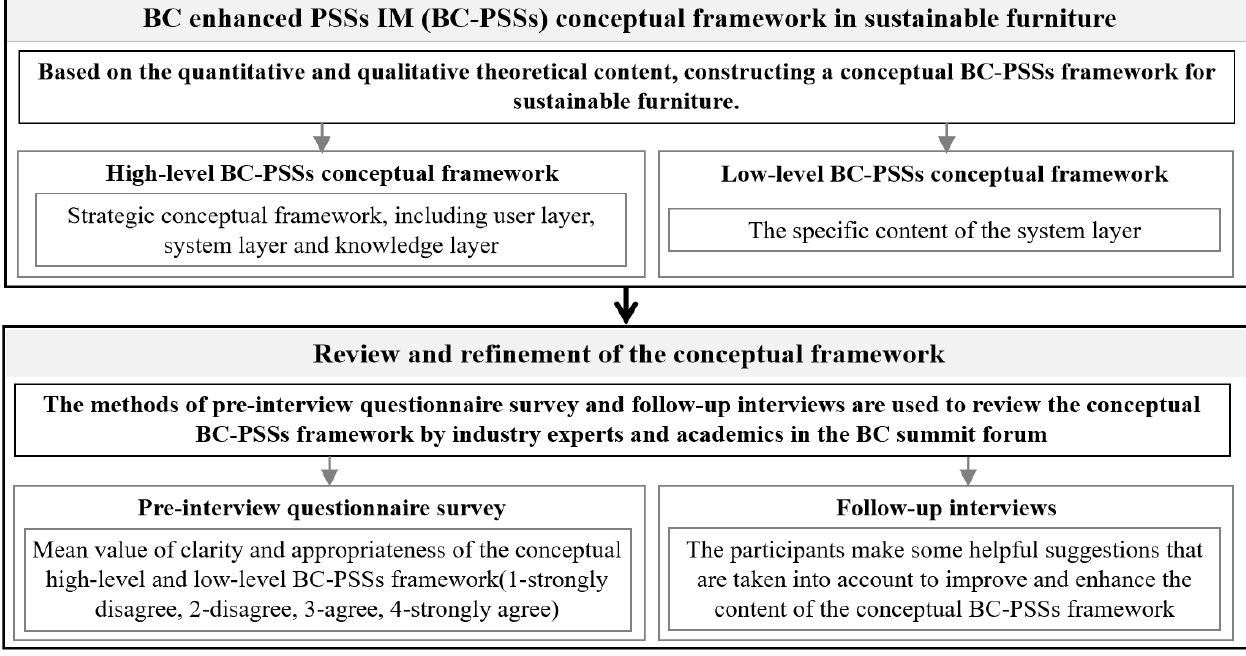
Figure 1. The flow chart of the research methodology (generated by authors).